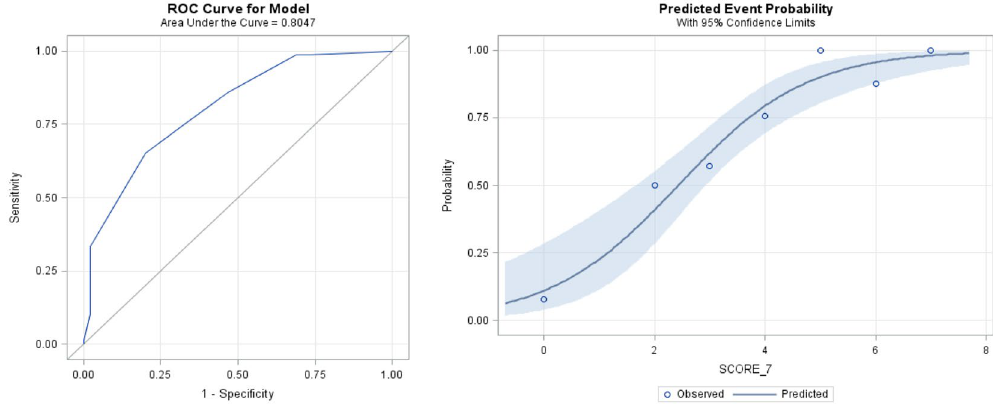
Figure 3. ROC analysis for the model with seven variables (VOS; halo sign, crazy paving, nodules, infarct shaped infiltrate, cavern and air-crescent sign) with an area under curve (AUC) of 0.805. The image on the right shows predicted event probability and the bands of 95%-confidence limits for the model with the seven